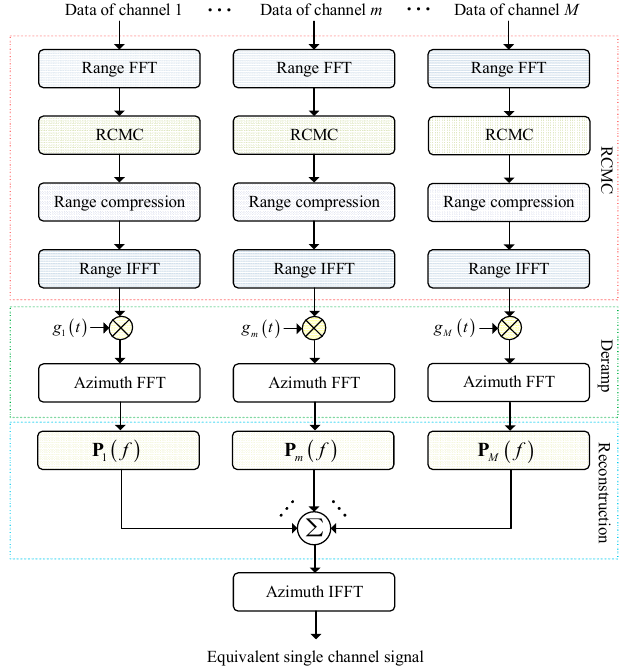
Figure 9. Flowchart of the proposed multichannel reconstruction approach.